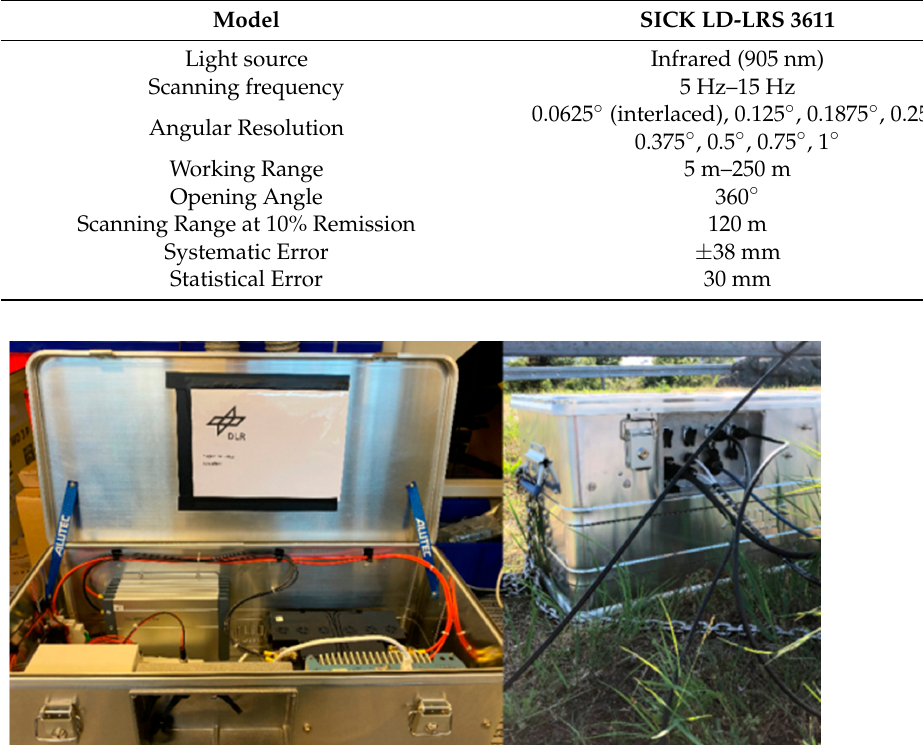
Figure 5. ( a ) Prototype implementation of SmartKai in the port of Wilhelmshaven, Germany. Red dots mark the position of two 2D LiDAR sensors. ( b ) Resulting LiDAR data from 2D LiDARs installed at the quay wall. Quay wall outline and a ship on the right image can clearly be seen. Table 1. LiDAR specifications SICK LD-LRS 3611.